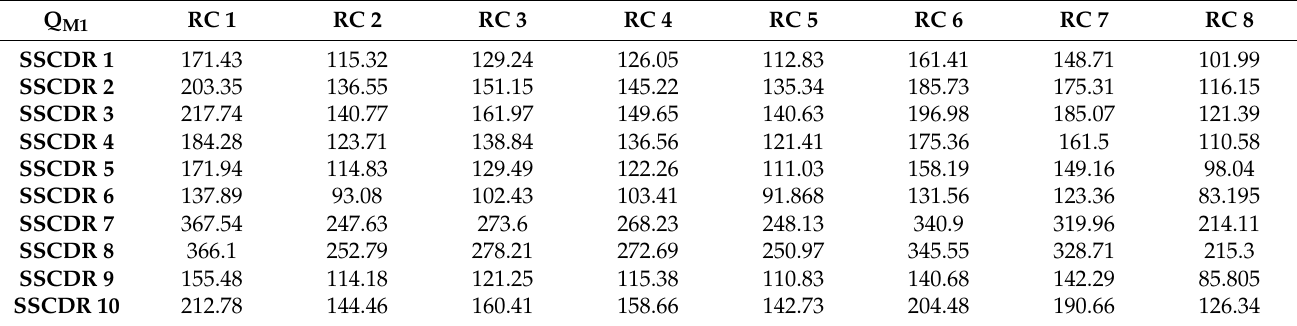
Table 7. Integrated evaluation matrix of SSCDRs and RCs (Q M1